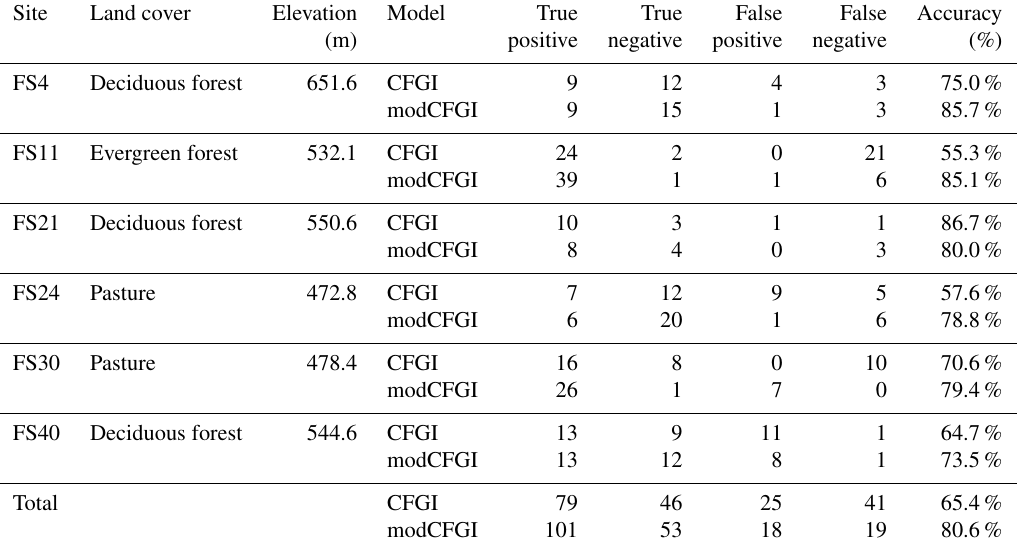
Table 6. Number of true positive (both simulated and observed data show frost depth), true negative (both simulated and observed data show no frost depth), false positive (simulated data shows frost depth but observed data does not), and false negative (simulated data shows no frost depth but observed data shows frost depth) occurrences during the entire test period. The Accuracy is the sum of the true positive and true negative divided by the total number of